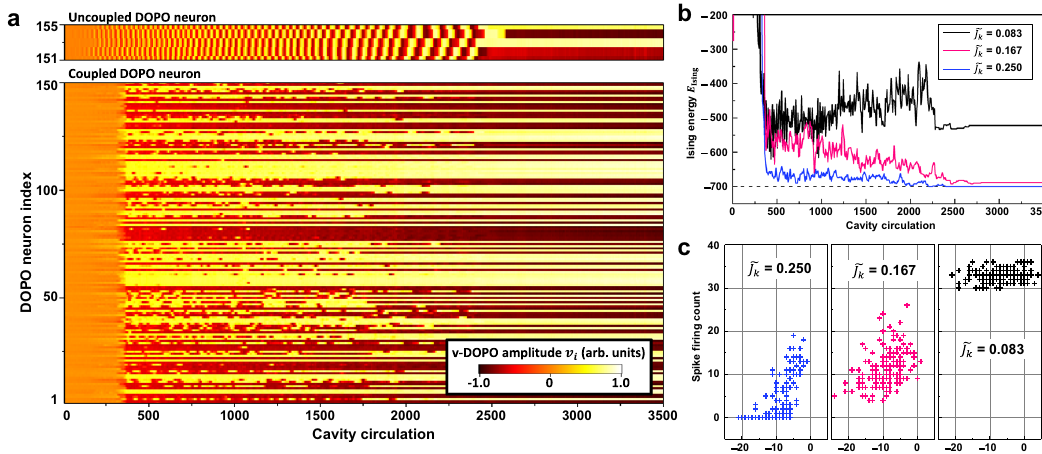
Fig. 4 Spiking dynamics when solving a 150-node Ising problem. a Time evolutions of v -DOPO amplitudes with couplings of e J k = 0.250 (lower) and without coupling (top). Pump amplitudes increase linearly with time. b Time evolutions of Ising energy for e J k = 0.083, 0.167, and 0.250. Strong couplings give the best-known solution. c Relationship between local energy and fi ring rate. Firing rate and local energy are positively correlated with strong couplings, suggesting that energetically unstable neurons have high fi ring rate due to the self-tuning effect of the spiking